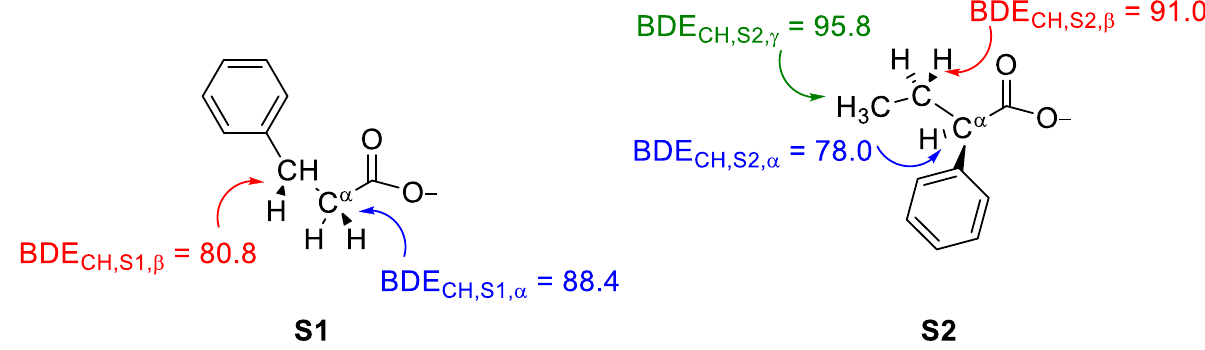
∆ E+ZPE in kcal mol − 1